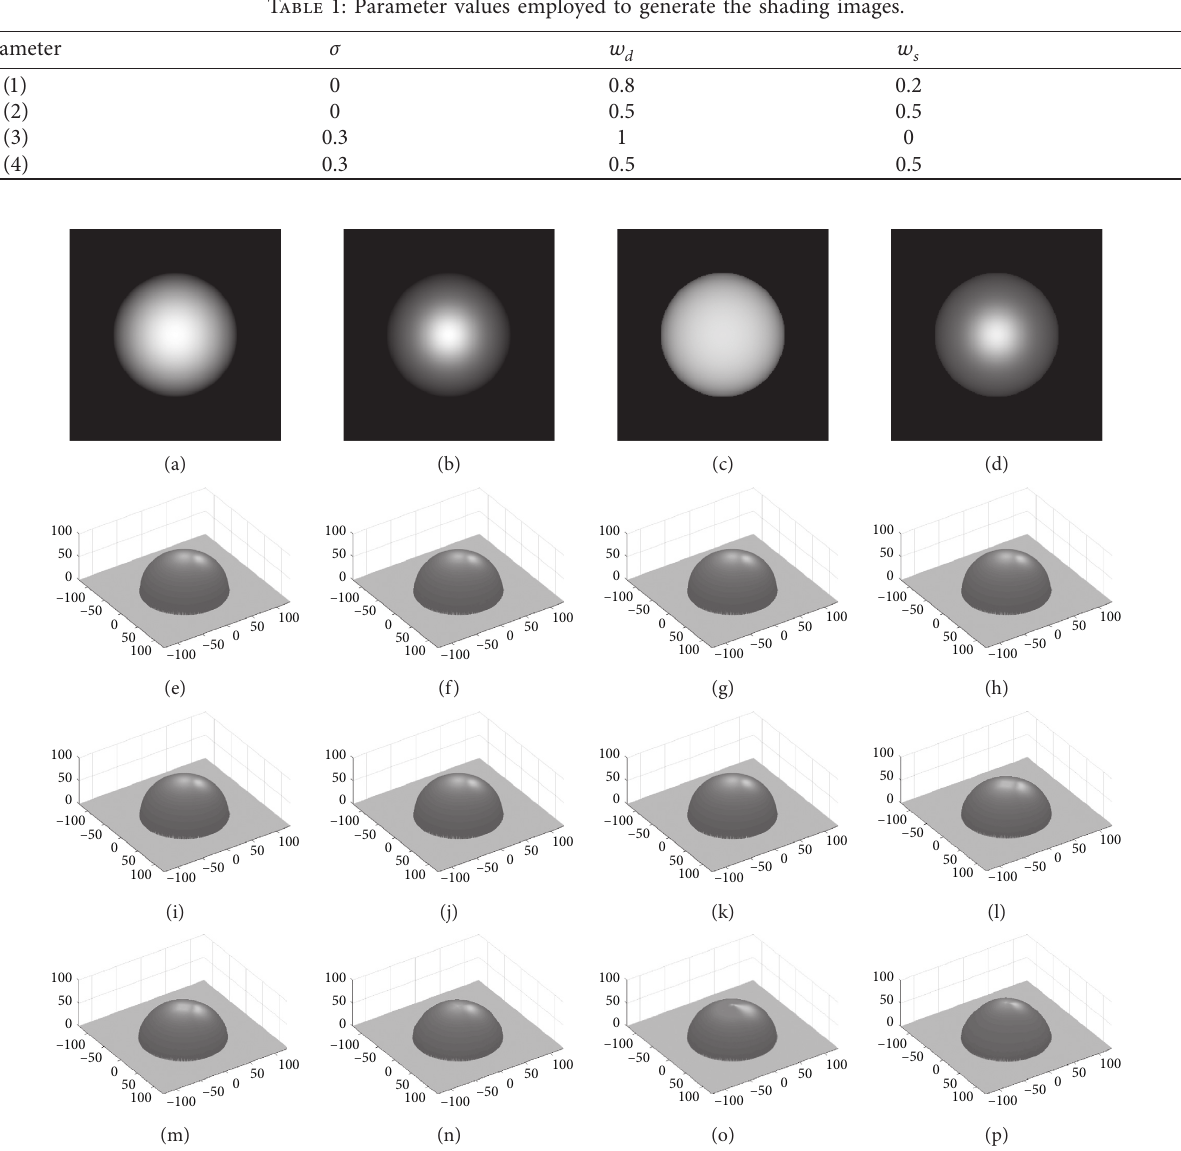
Figure 3: Experimental results for the synthetic ball images. (a)–(d) The shading images generated by the four parameter sets shown in Table 1. (e)–(h) Reconstructed surfaces of (a)–(d) using first-order Godunov-based scheme. (i)–(l) Reconstructed surfaces of (a)–(d) using high-order Godunov-based scheme. (m)–(p) Reconstructed surfaces of (a)–(d) using Lax-Friedrichs sweeping scheme.